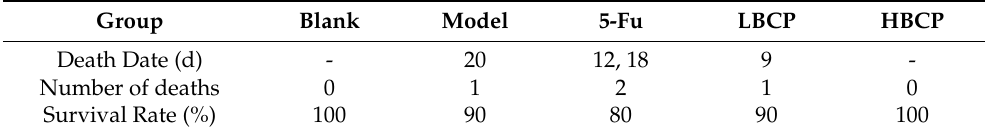
Table 1. The survival rate of mice.